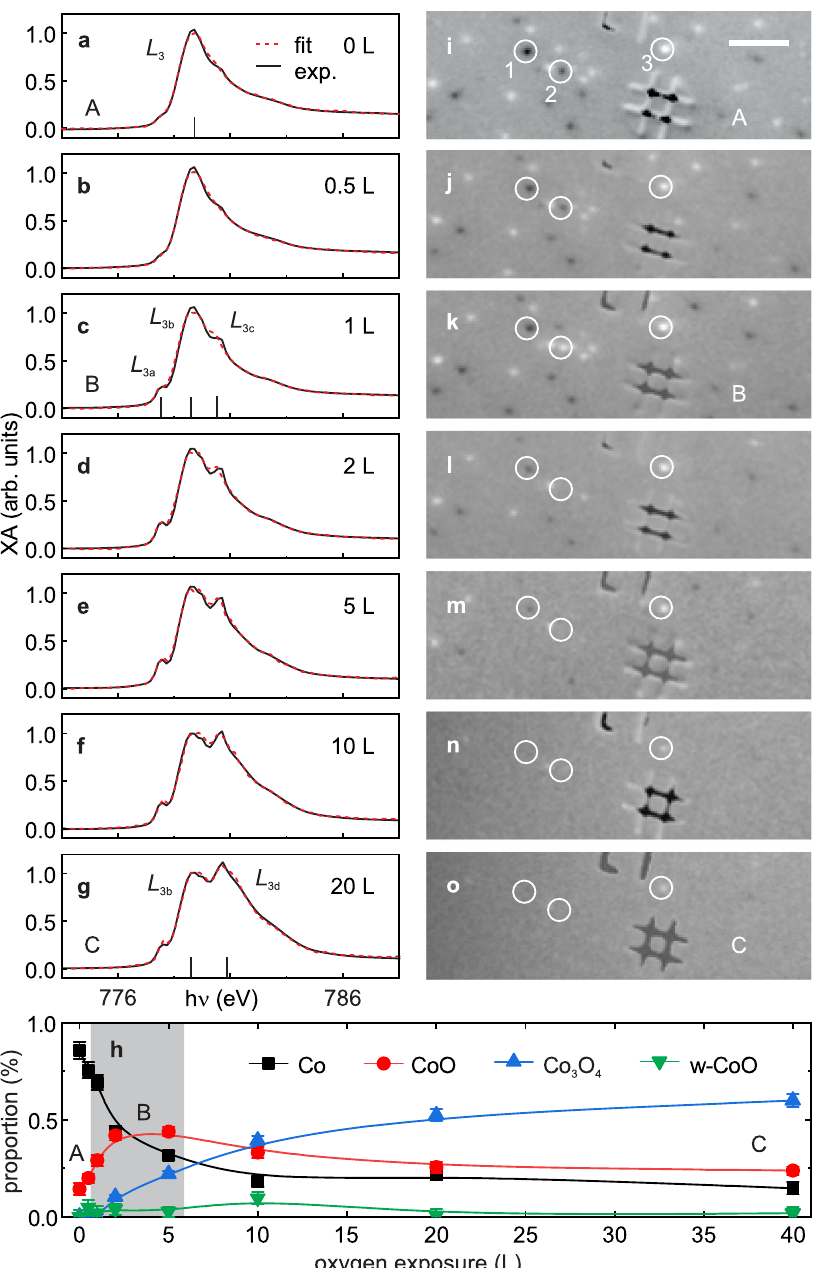
Fig. 2 | Evolution of the chemical and magnetic states of Co nanoparticles deposited onSi/SiO x during insituoxidation.a – g X-rayabsorption (XA)spectra with increasing molecular oxygen dosage in langmuir (L) (black lines). Speci fi c features at the Co L 3 edge of metallic Co and of the different cobalt oxides dis- cussedinthetextareindicatedin a , c , g .Reddashedlinesare fi tstotheXAspectra. h Relative proportion of Co, CoO, wurtzite-CoO (w-CoO), and Co 3 O 4 as a function of oxygen dosage obtained from a chemical composition analysis. The lines are